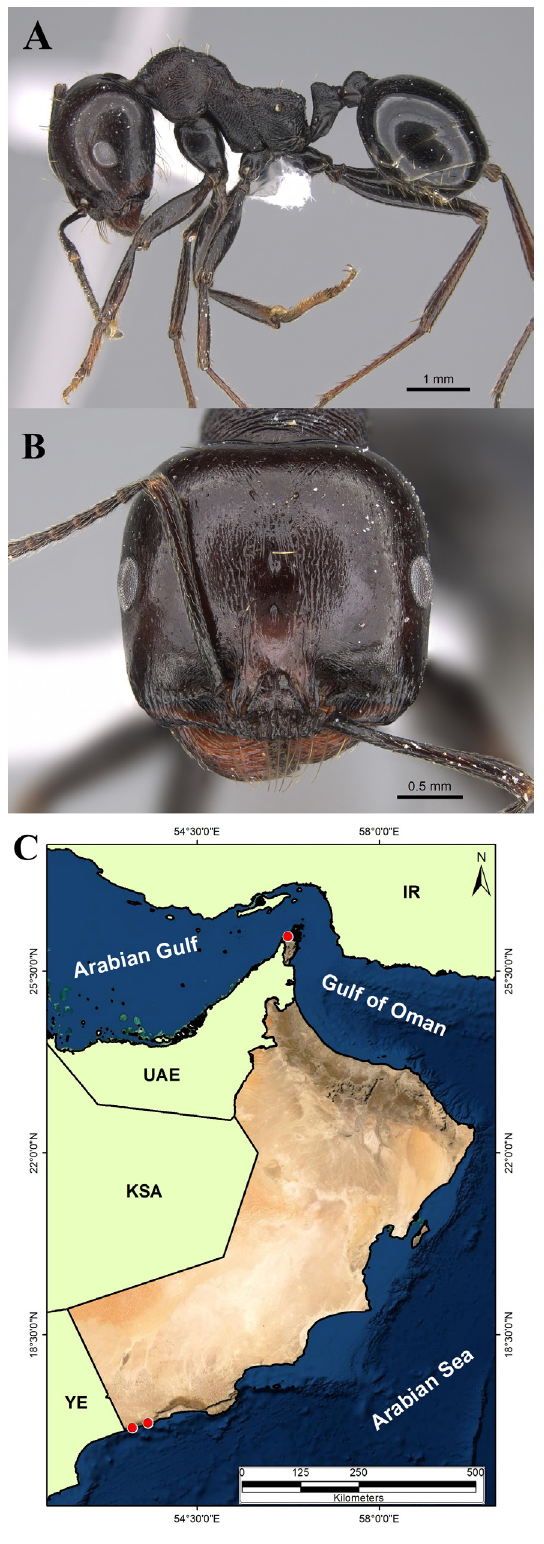
Fig. 34. Messor ebeninus Santschi, 1927, major worker (CASENT0922882, AntWeb.org (Michele Esposito)). A . Body in profile. B . Head in full-face view. C . Distribution